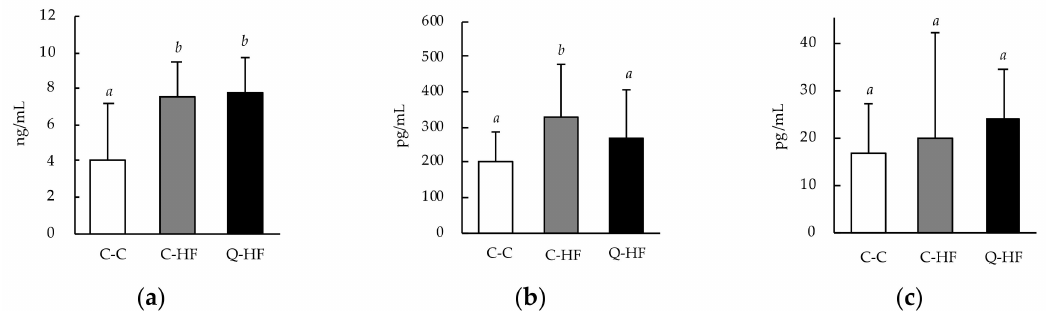
Figure 5. Effects of maternal quercetin consumption on blood metabolic hormones and myokines. Male progeny of dams fed a control diet (C) or a diet containing 1.0% quercetin (Q) were divided into three groups: progeny of dams fed the C-diet that were also fed the C diet (C-C), progeny of dams fed the C-diet that were fed a 30% high-fat (HF) diet (C-HF), and progeny of dams fed Q-diet that were fed a HF-diet (Q-HF). The animals were permitted free access to deionized water and the C-diet or HF-diet for 13 weeks, and then their plasma parameters were analyzed: ( a ) leptin; ( b ) gastric inhibitory polypeptide (GIP); ( c ) monocyte chemotactic protein-1 (MCP-1). Data are shown as the mean ± SD ( n = 10). Different superscripts ( a , b ) indicate significant differences ( p <